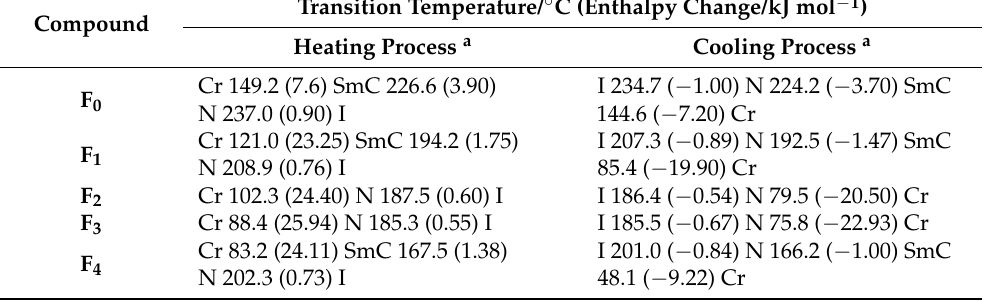
Table 1. Types of mesophases, transition temperatures and corresponding enthalpies obtained by POM and DSC methods for compounds F 0 – F 4 .